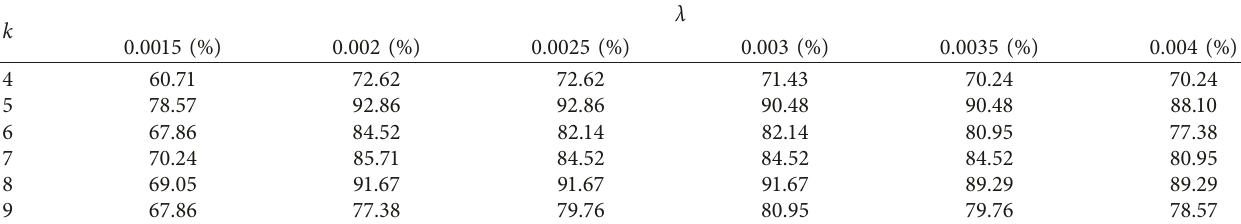
Table 5: Cross-validation set identification